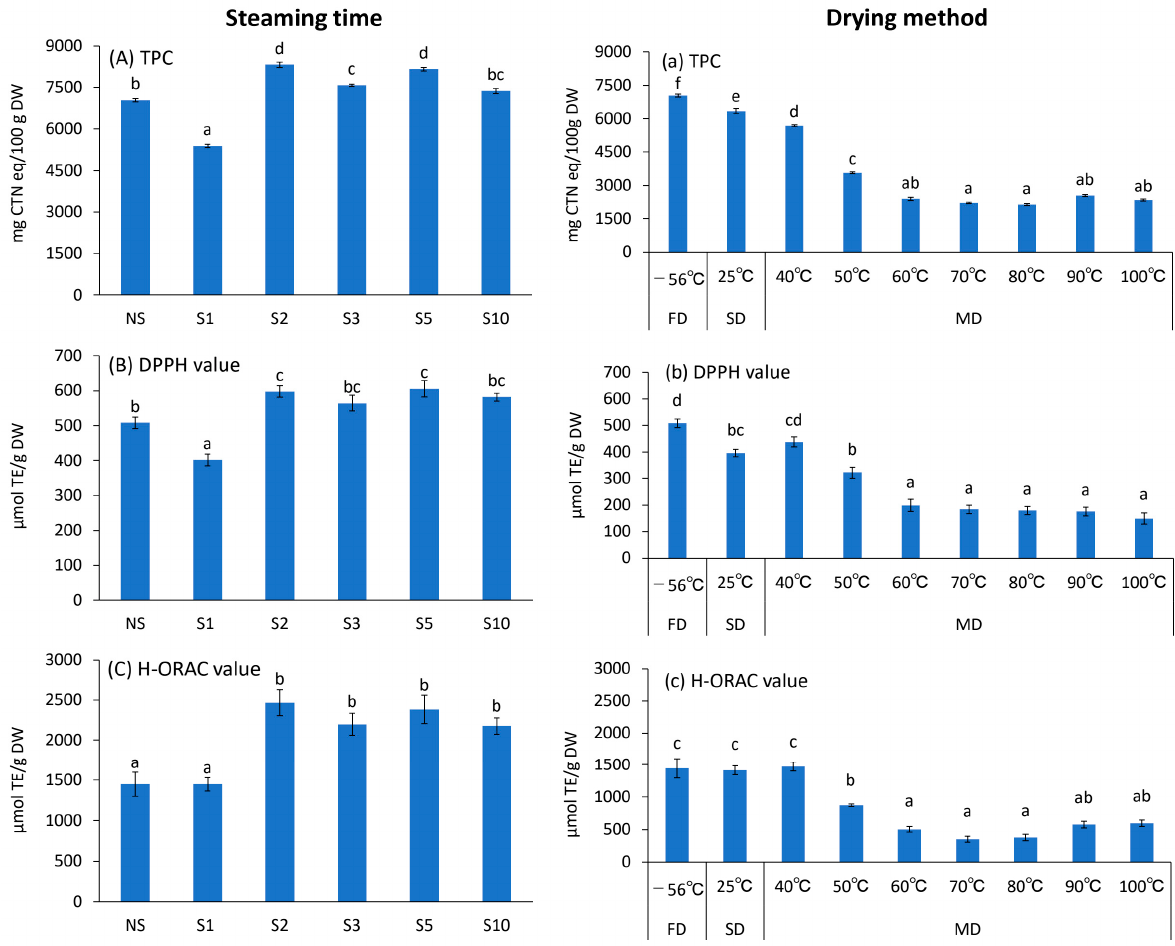
Figure 4. E ff ects of di ff erent treatment conditions on ( A, a ) TPC, ( B, b ) DPPH, and ( C, c ) H-ORAC values of Ocimum basilicum cv. ‘Genovese’ tea. FD: Freeze-drying (–56 °C, 48 h), NS: Non-Steaming, S1: Steaming for 1 min, S2: Steaming for 2 min, S3: Steaming for 3 min, S5: Steaming for 5 min, S10: Steaming for 10 min, SD: Shade-drying (25 °C, 7 days), MD 40 °C: Machine-drying at 40 °C, MD 50